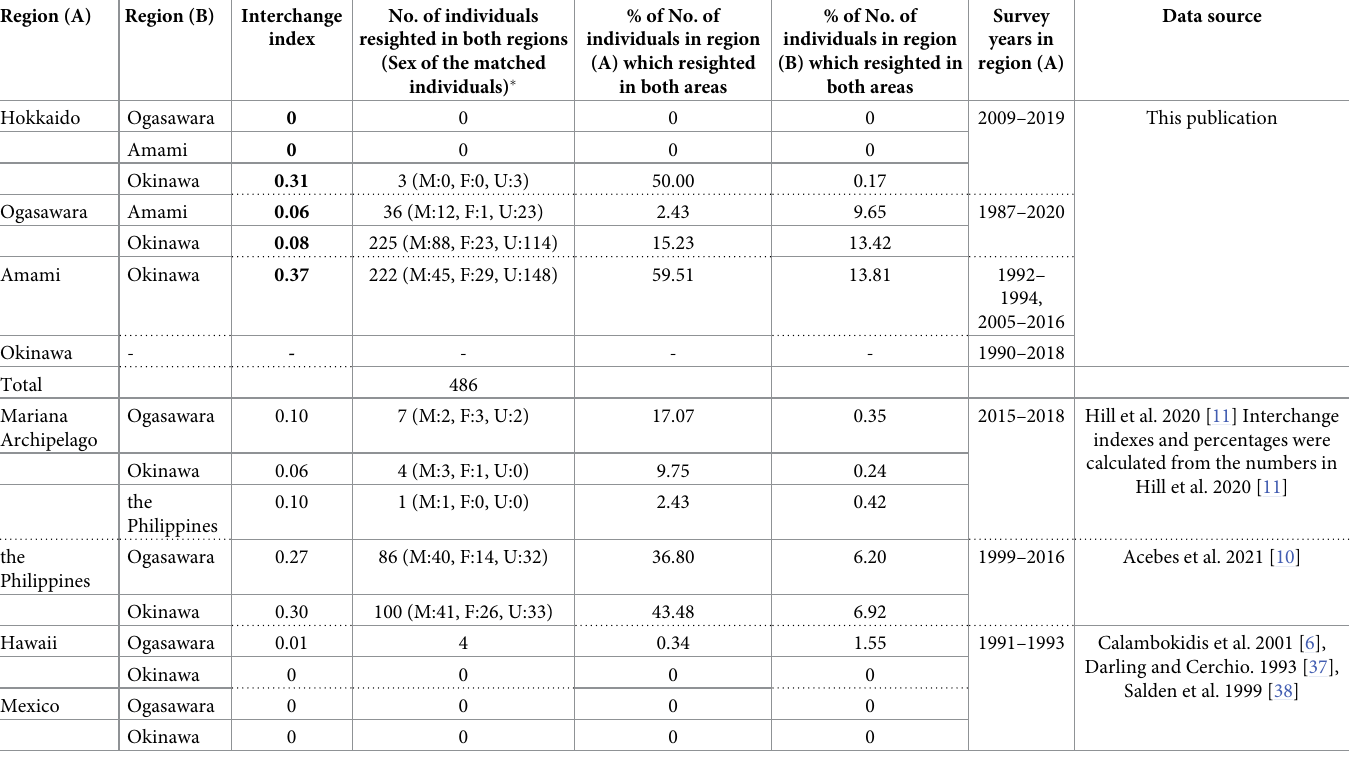
Table 2. Interchange indices, proportions (%) and the actual number of matched individuals in two different